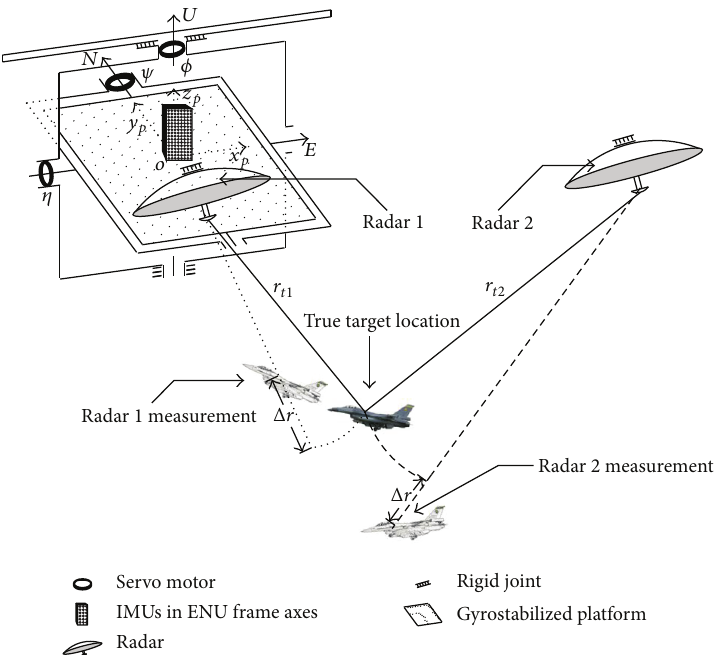
Figure 1: The diagram of mobile radar installed on the gyrostabilized